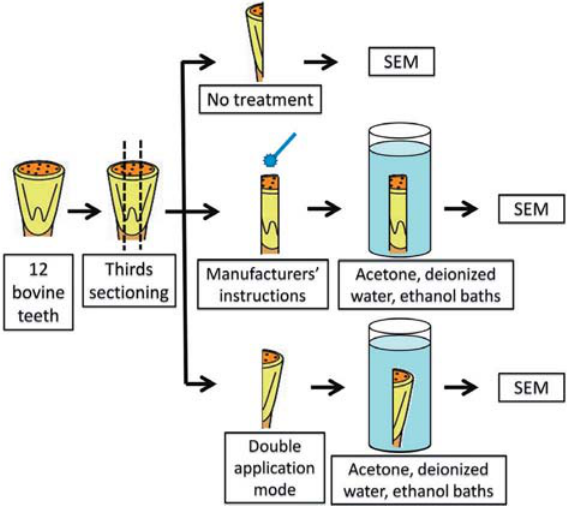
Figure 3- Flowchart of the etching pattern examined by scanning electron microscopy